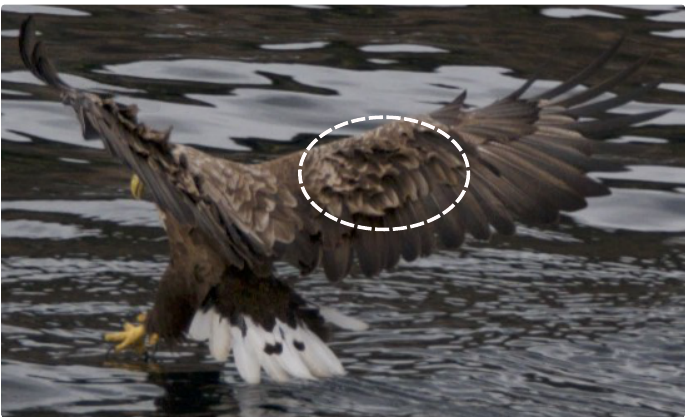
Figure 1. Raising of passive feathers of a white-tailed eagle before catching prey in